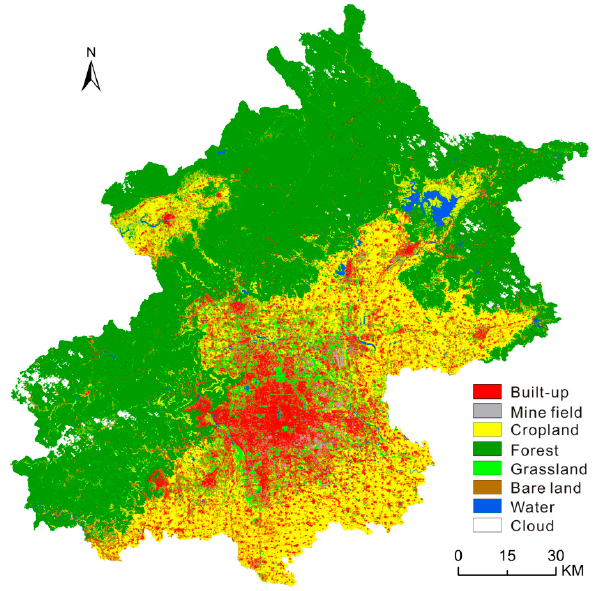
Figure 4. Land cover map in Beijing.